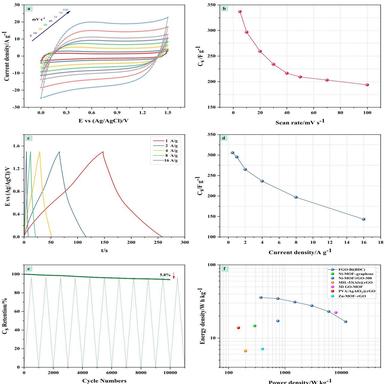
a) CV curves and b) Cs values at different scan rates for the FGO-Bi(BDC)//FGO-Bi(BDC) electrode; c) GCD curves and d) Cs values at different current densities for the FGO-Bi(BDC)//FGO-Bi(BDC) electrode; e) Cs retention over 10,000 cycles at 8 A g− 1 ; and f) Ragone plot of the FGO-Bi(BDC)//FGO-Bi(BDC) electrode compared with other research.